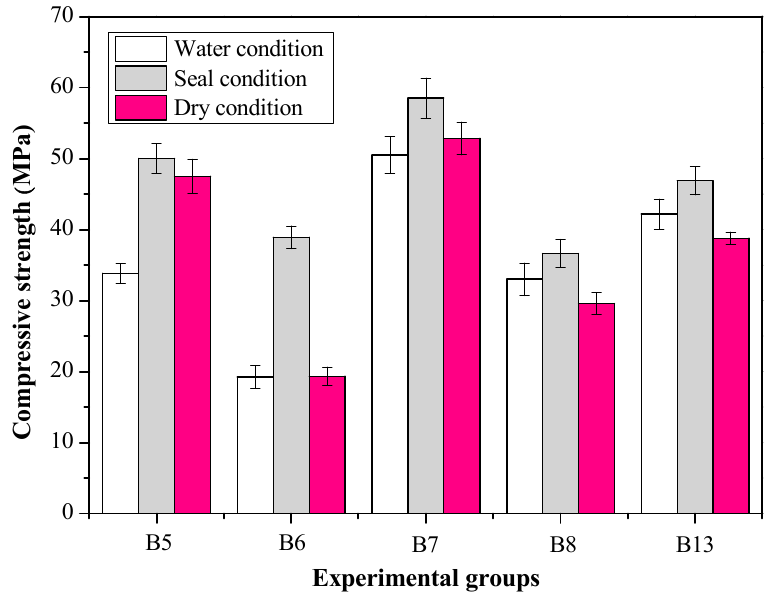
Figure 2. Effect of curing conditions on the 28-day compressive strengths of AA-FASM. Another change to note is that the strength of the sample with R A = 55% (B6 or B8) was lower than that of the sample with R A = 45% (B5 or B7), which may be related to the